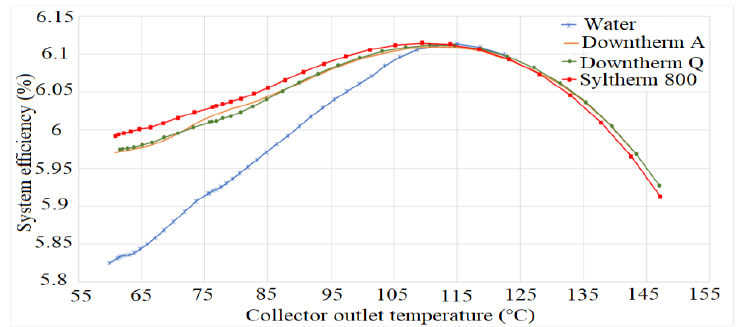
Figure 9. The system’s overall efficiency is a function of the temperature at the outlet of the collector.